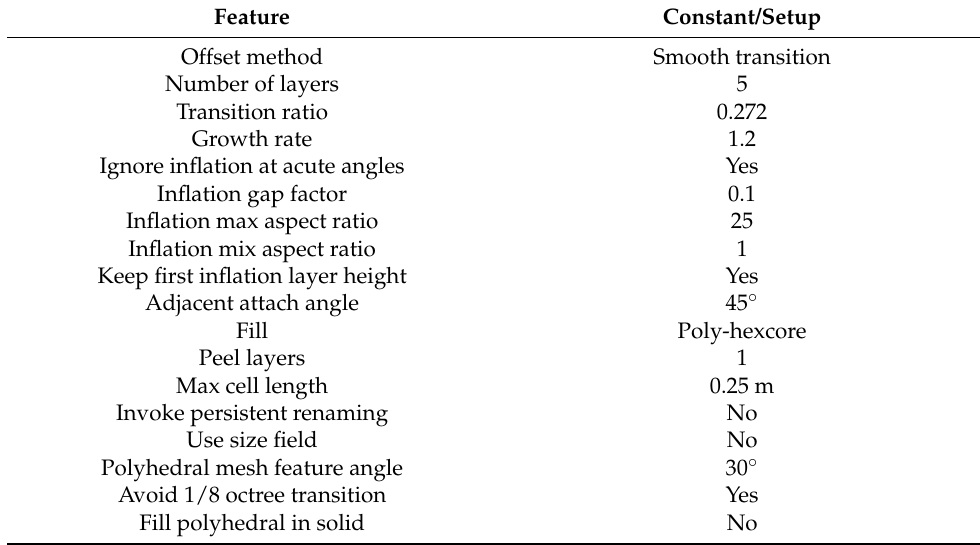
Table 3. Features used in preparation of surface mesh.